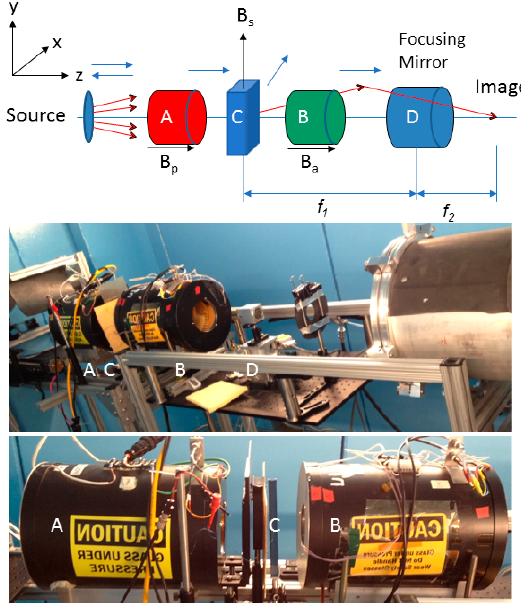
Figure 2. Layout sketch and two photographs of the WHIMS experiment. The beam travels left to right along the positive z-direction. Visible in the top photograph are the 3 He polarizer (labeled with a white A), 3 He analyzer (labeled with a white B), the Wolter optic inside the small aluminum box (labeled with a white D), beam-limiting aperture, and the evacuated beam tube. In the bottom photograph, the polarizer solenoid, the sample solenoid (labeled with a white C) placed in the focal plane of the Wolter optic, and the analyzer solenoid are shown. Due to the use of solenoidal holding fields, the neutron polarization axis, shown as blue arrows in the sketch, is along the z-direction. The longitudinal magnetic fields from the magnetically shielded polarizer and analyzer solenoids drop off rapidly but are sufficient to maintain the neutron’s spin direction. Since they are roughly an order of magnitude lower than that of the sample solenoid’s vertical field, they were not include in the analysis. The sample field, B s , is along the y-axis, thus causing the neutron spin vector to rotate in the x-z plane. The detector is far beyond the left edge of the photograph.